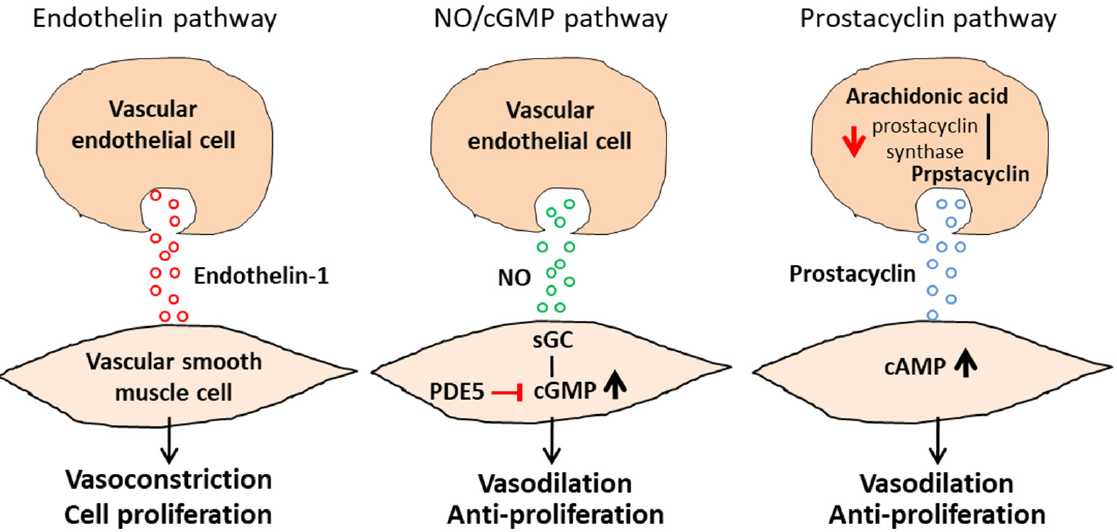
Figure 1. Three conventional pathways in PAH pathogenesis. In the endothelin pathway, vascular endothelial cells release endothelin-1, which induces vascular smooth muscle proliferation and vasoconstriction. In the NO/cGMP and prostacyclin pathway, the functional anti-proliferative and vasodilative ability of NO and prostacyclin signaling are hindered by PDE5 and prostacyclin synthase deficiency, respectively, which result in vascular smooth muscle proliferation and vasoconstriction, and further PAH pathogenesis. Red arrow: downregulated; Black arrow: upregulated.